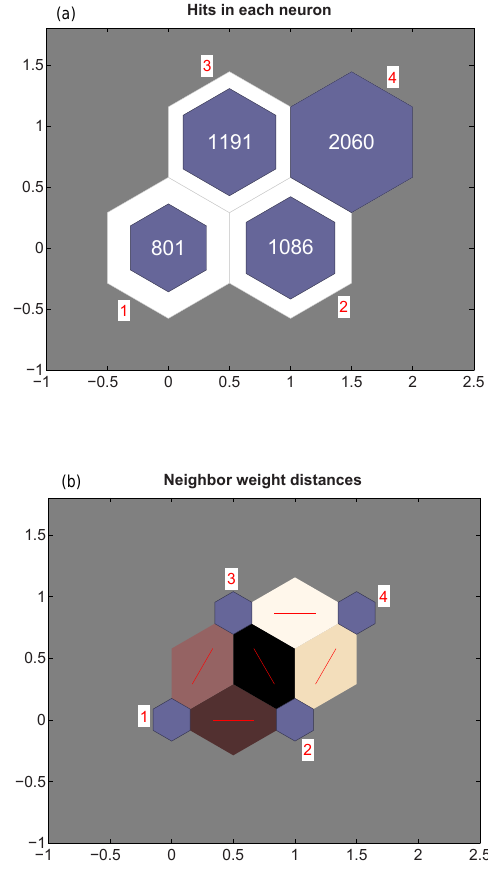
Figure 2. (a) Number of hits in each neuron (blue hexagons). (b) Connecting neighboring neurons (red lines). The colors in the regions containing the red lines indicate the distances between neu- rons, where darker colors represent larger distances and lighter col- ors represent smaller distances. The red numbers correspond to the number of the